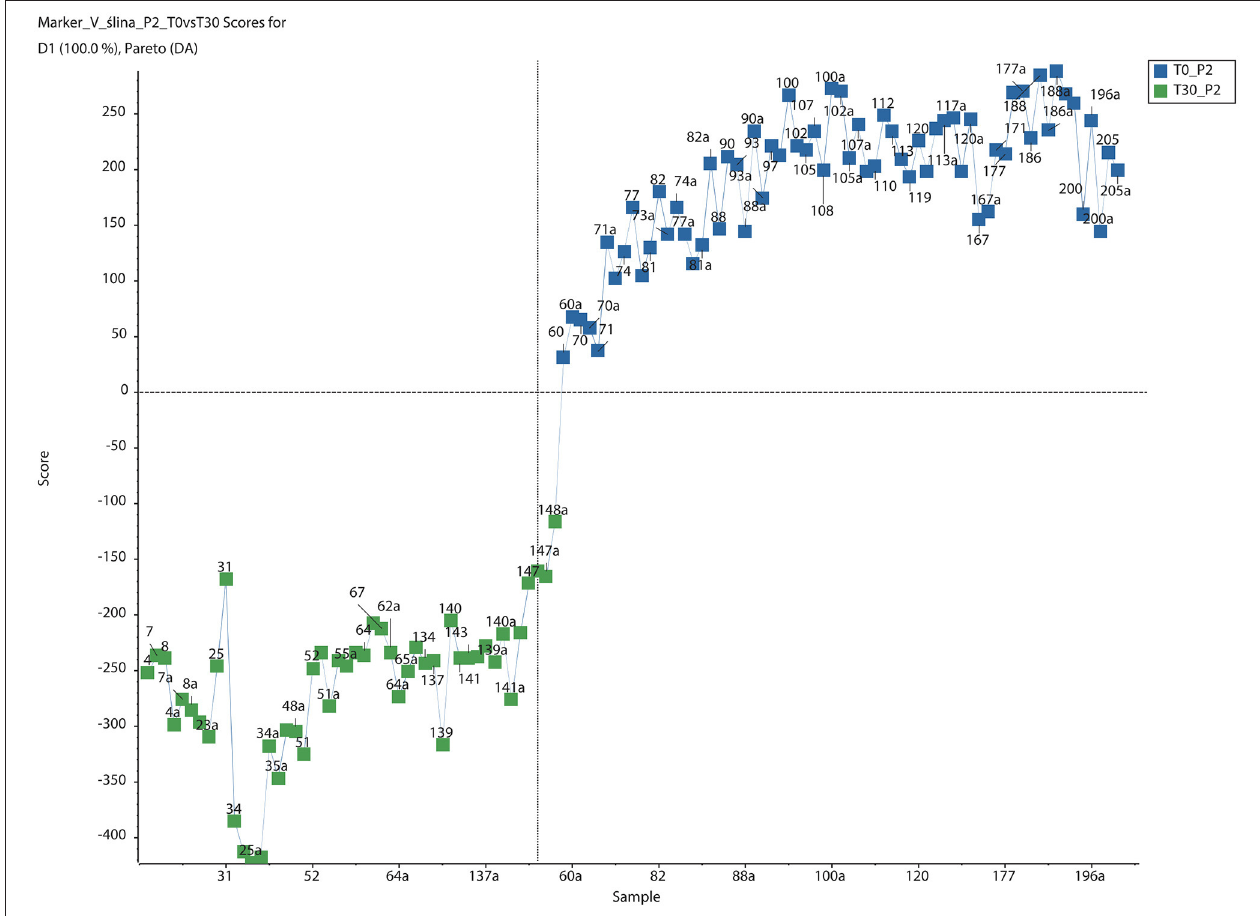
FIGURE 2 | PCA-DA Score plots for saliva of dogs after 30-day-long period of Ascophyllum nodosum administration. Green boxes and blue boxes represent metabolome of sample from dogs in day 0 and day 30 after Ascophyllum nodosum administration, respectively (PCA-DA, Scaling PARETO, SCIEX MarkerView TM